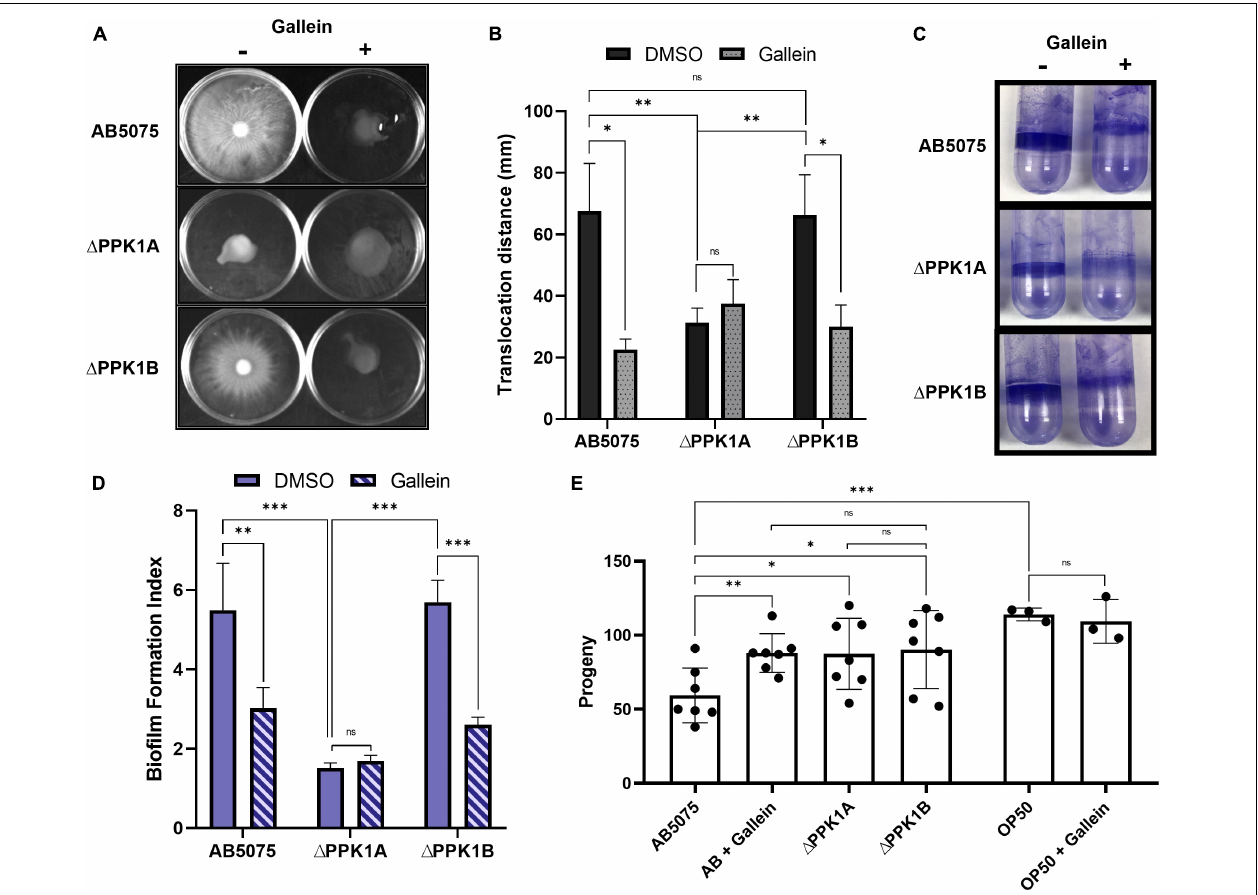
FIGURE 4 | Gallein phenocopies PPK1 knockouts to attenuate A. baumannii virulence. (A) Representative image of 100 µ M gallein treatment and PPK1 knockout on A. baumannii surface-associated motility. Image is representative of n = 4 assays. (B) Quantification of gallein treatment and PPK1 knockout on surface-associated motility. All gallein samples and (cid:49) PPK1A DMSO are not significantly different. (C) Representative image of 100 µ M gallein treatment and PPK1 knockout on A. baumannii biofilm formation. Image is representative of n = 3 assays. (D) Quantification of gallein treatment and PPK1 knockout on biofilm formation. (E) Progeny count of C. elegans following feeding with A. baumannii strains ( n = 7) or OP50 ( n = 3). Symbols are as follows: ns, p > 0.05; ∗ p < 0.05; ∗∗ p < 0.01; ∗∗∗ p < 0.001. For (B,D) two-way ANOVA, Tukey’s multiple-comparison test; (E) two-way Unpaired Welch’s t -test. Data points are the average of triplicates or more; error bars are ±